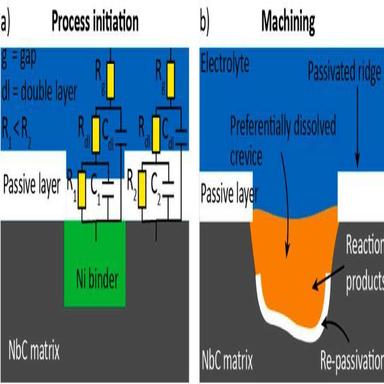
Proposed mechanism for ridge and crevice surface pattern formation during NbC–Ni ECM/LECM.